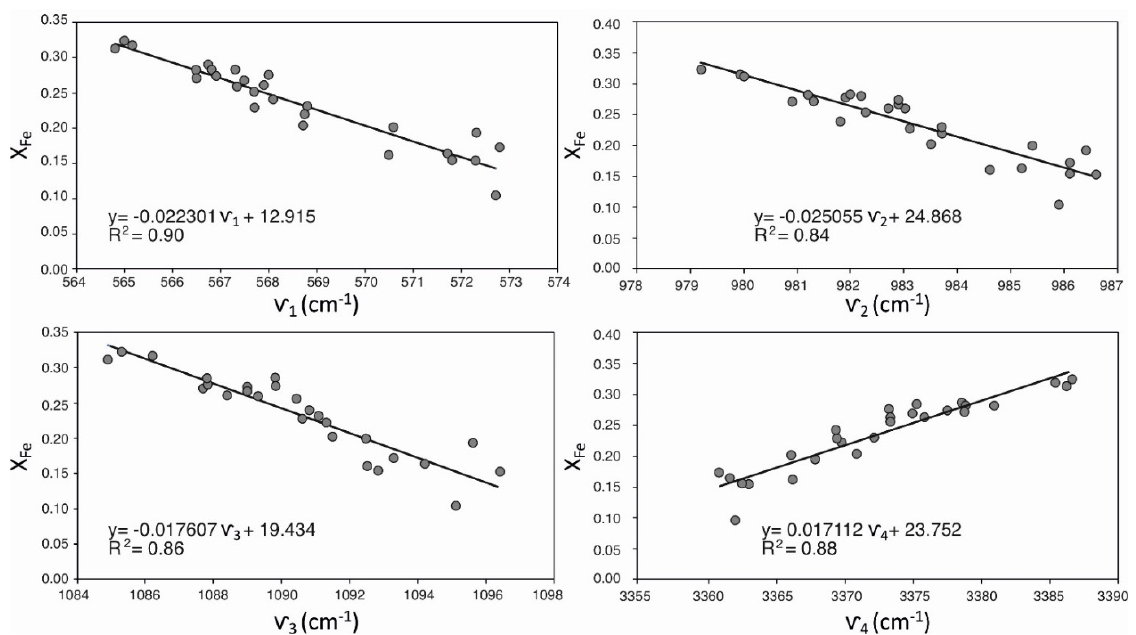
Figure 5. Correlation between Raman peak positions and chemical composition (X Fe determined by SEM–EDS) in the six epidote and clinozoisite standards.